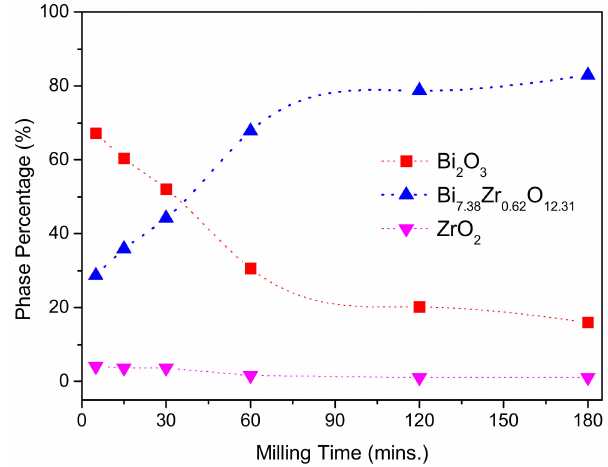
Figure 2. The percentage of the individual phase of (Bi 2 O 3 ) 95 (ZrO 2 ) 5 after di ff erent milling times. Table 1. Crystalline phases of (Bi 2 O 3 ) 95 (ZrO 2 ) 5 as a function of the milling time. Milling Condition